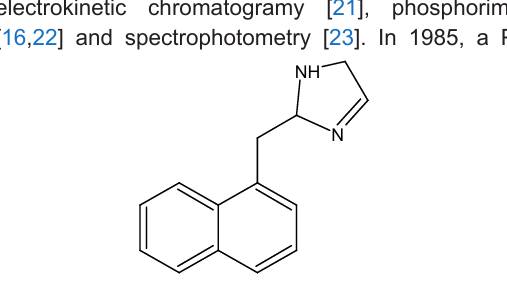
Figure 1. Basic structure of